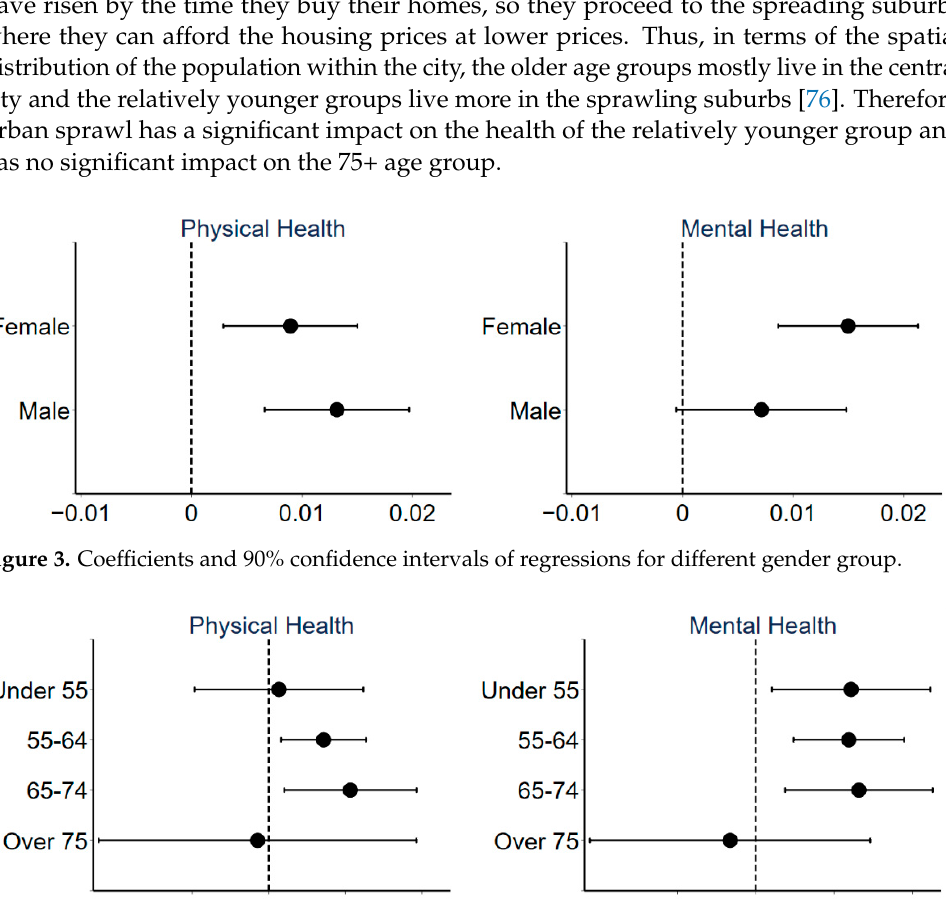
Figure 2. Coefficients and 90% confidence intervals of regressions for each psychological feeling.